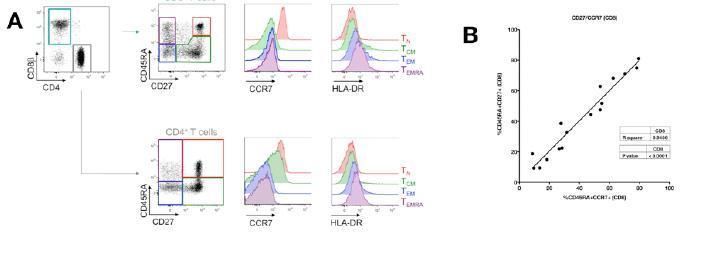
Evaluation of CD45RA/CD27 gating strategy.CD45RA+CD27+ naïve CD4+ and CD8+ T cells express the highest levels of CCR7 and lowest level of HLA-DR markers (A). Also, there is a close correlation between CD45RA+CD27+ and CD45RA+CCR7+- gated naïve CD8+ T cells (B).